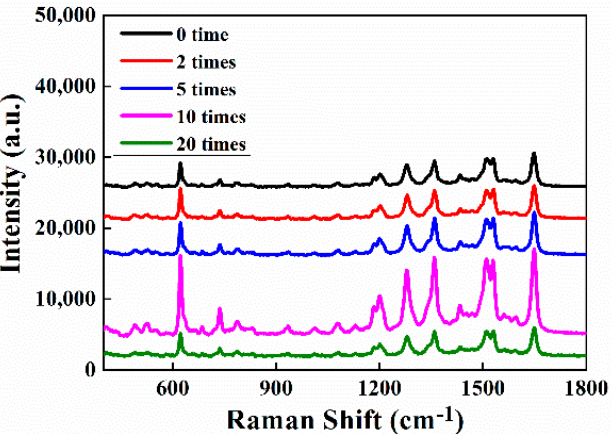
Figure 4. Raman spectra of R6G on ITO/Au prepared by using different concentrations of Au NP sols.